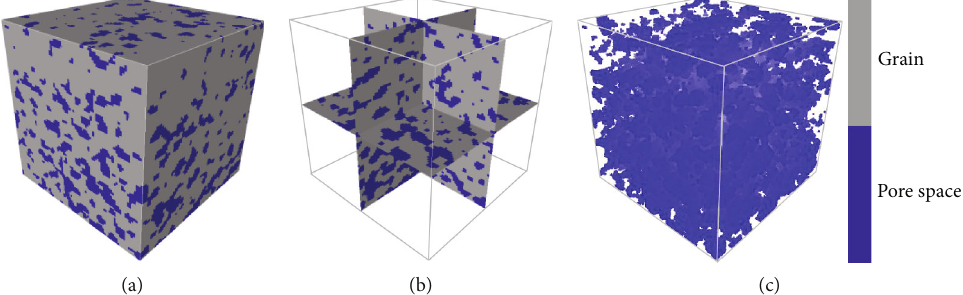
Figure 8: The TI (training image) of shale: (a) exterior; (b) cross-section ( X = 40 , Y = 40 , and Z = 40 ); (c) pore space.